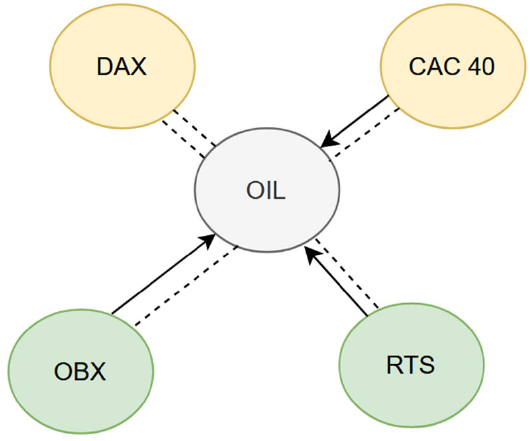
Figure 4. Granger causality results (post-vaccine period).